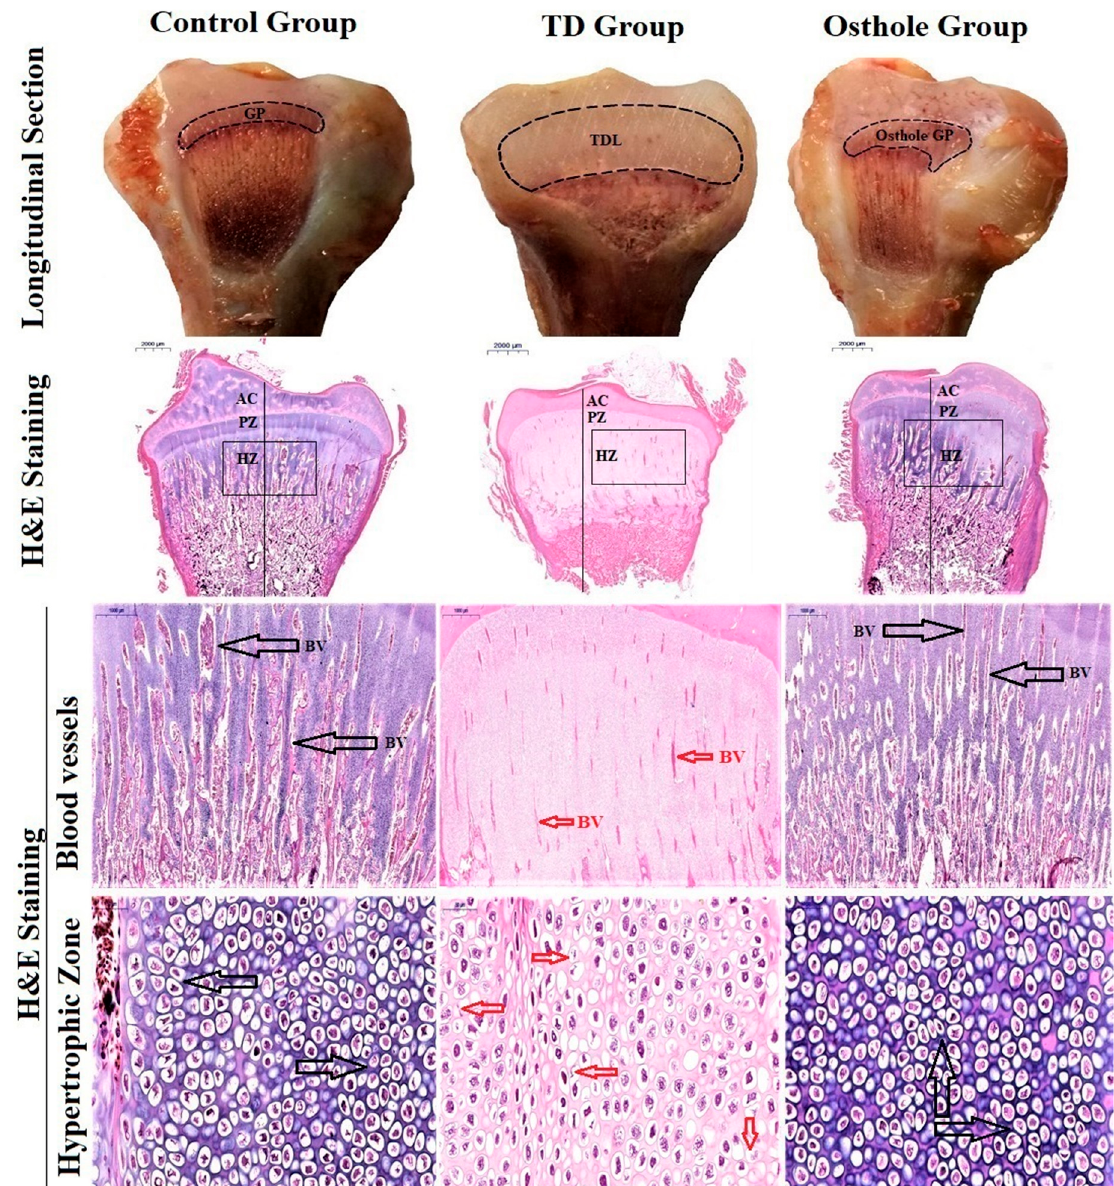
Figure 9. Growth plate morphological changes in the tibia (longitudinal section). H&E staining of tibia bones. The black arrows indicate blood vessels and a firmly arranged column of chondrocytes in the control and osthole groups. The red arrows indicate wrecked and dead cells having a disintegrated nucleus with less vascularity in the TD group. Key: Growth plate (GP), blood vessels (BV), tibial dyschondroplasia lesion (TDL), articular cartilage (AC); proliferative Zone (PZ), hypertrophic zone (HZ).